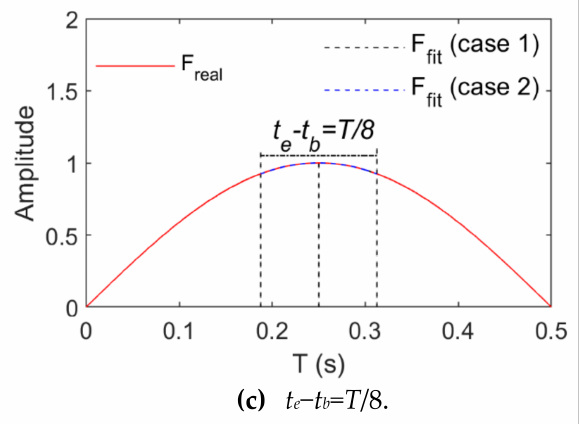
Figure 5. Comparison between real and fitting values of harmonic loads ( f = 1 Hz).